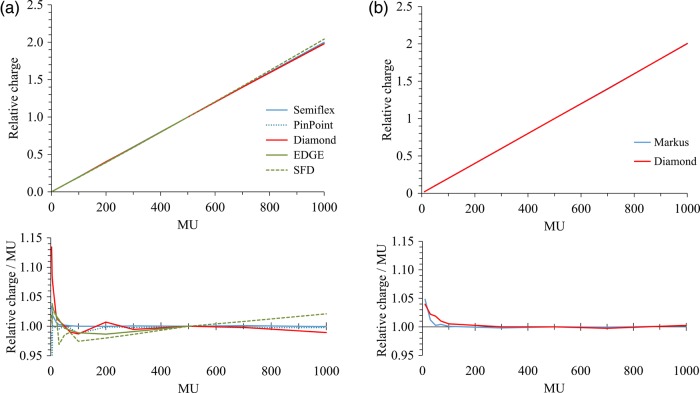
Dose linearity of (a) a 6-MV photon beam and (b) a uniform-scanning proton beam. For each detector, the dose/MU is plotted in the lower graphs. Values are normalized at 500 MU.